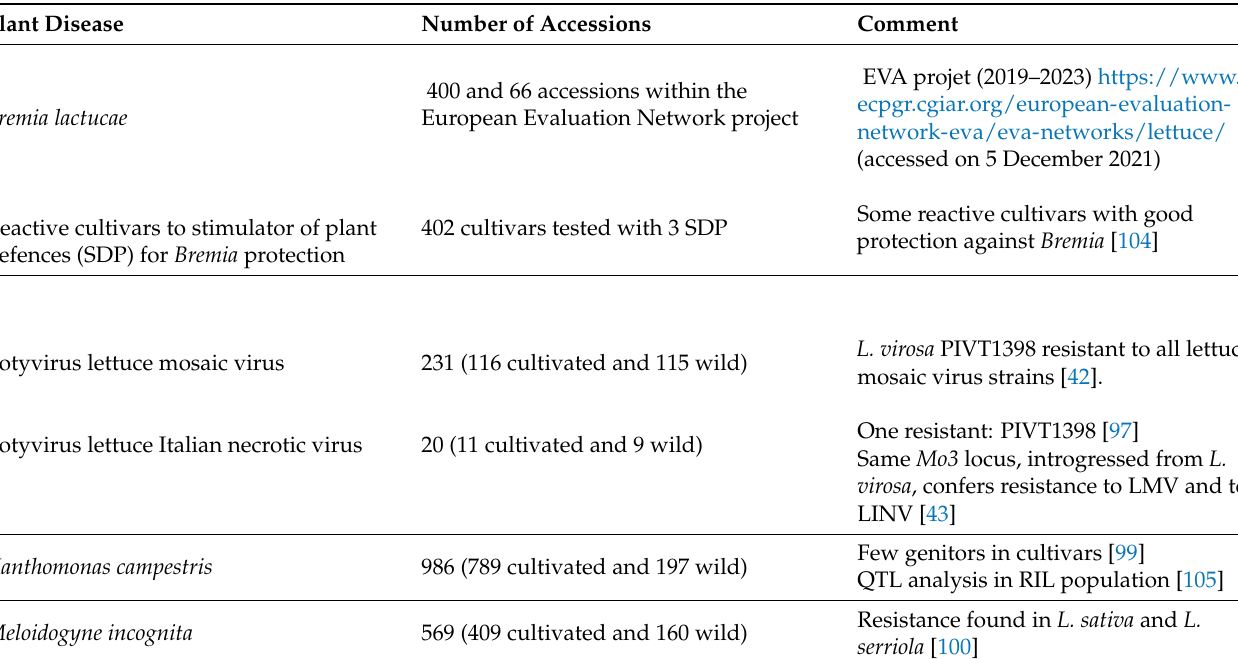
Table 3. Screening of the lettuce collection for resistance to pests and